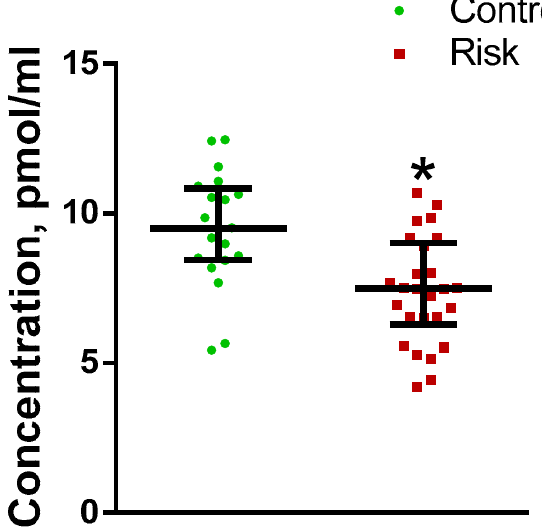
Figure 6. Plasma l-3,4-dihydroxyphenylalanine (L-DOPA) concentration in patients in the control group and in the risk group for developing Parkinson’s disease. * p < 0.05, statistically significant differences. Data presented as a median with an interquartile range and min–max values. In the risk group, the L-DOPA level in the blood plasma correlated with the results of the Sniffin’ Sticks test (r = 0.55, p = 0.012). In addition to assessing the changes in the concentration of L-DOPA in the plasma of patients in the risk group compared with the control, we assessed the plasma L-DOPA concentrations in two selected subgroups. The first subgroup included patients from the risk group with integral UPDRS ≤ 2 points, and the second subgroup included patients with integral UPDRS > 2.5 points. It was shown that the concentration of L-DOPA in the plasma was significantly reduced in the patients of both subgroups (Figure